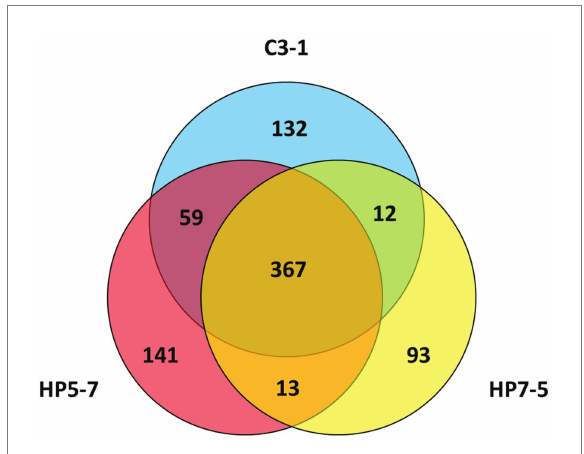
FIGURE 2 Venn diagram showing the number of mPing insertion sites and their overlap among the three